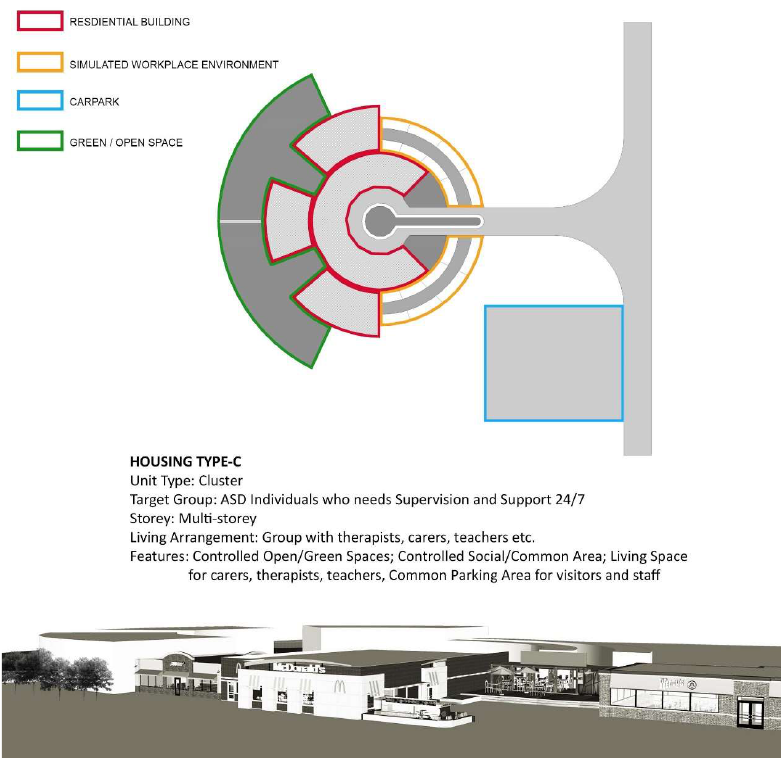
Figure 5. Proposed group home with simulated workplace environments.